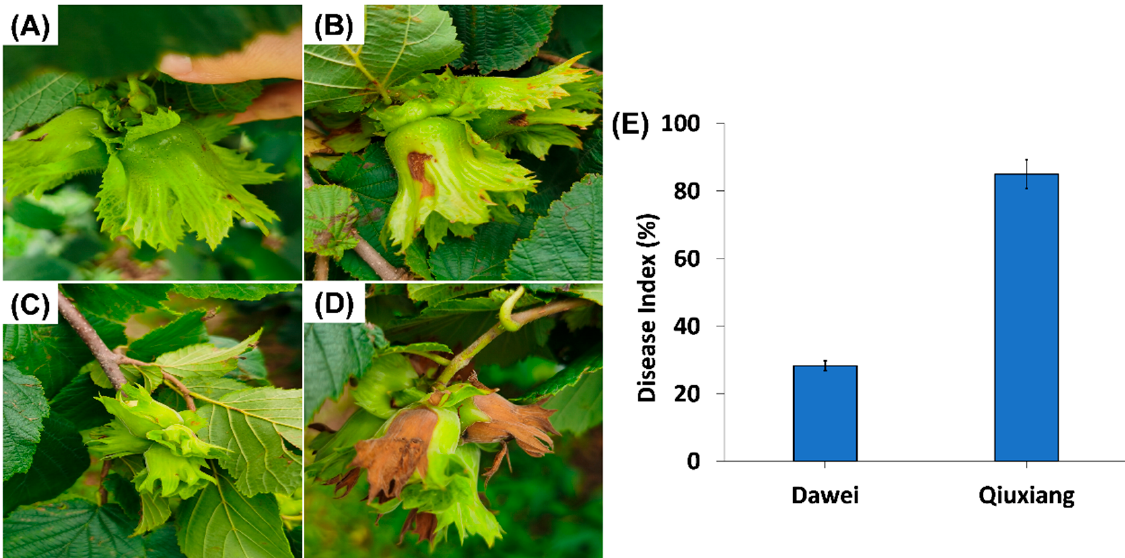
Figure 1. Disease occurrence in two hazelnut varieties infected by B. cinerea Z9. ( A , C ) are non-inoc- ulated controls for Dawei and Qiuxiang, ( B ) B. cinerea Z9 infected Dawei shows fewer symptoms, ( D ) B. cinerea Z9 infected Qiuxiang showing severe disease symptoms at 3 DPI and ( E ) Disease index (%) in Dawei and Qiuxiang.